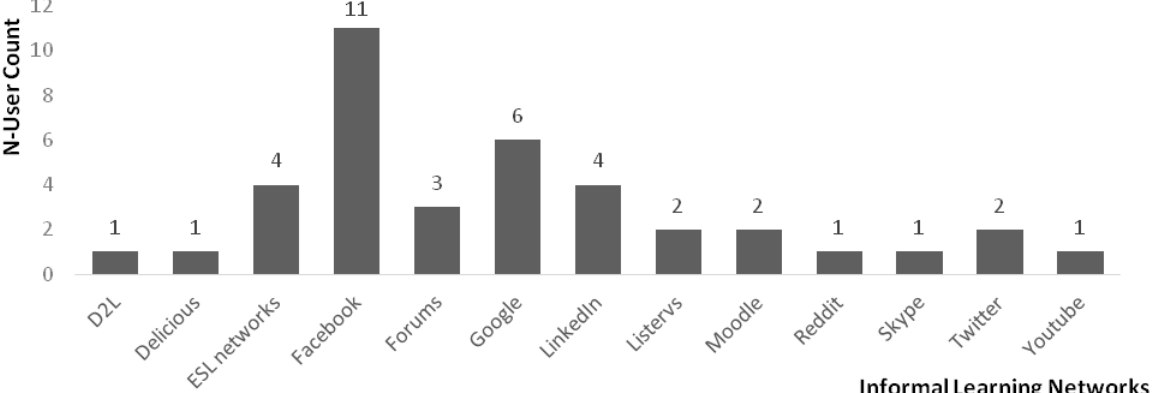
Figure 1 . Informal learning networks identified by